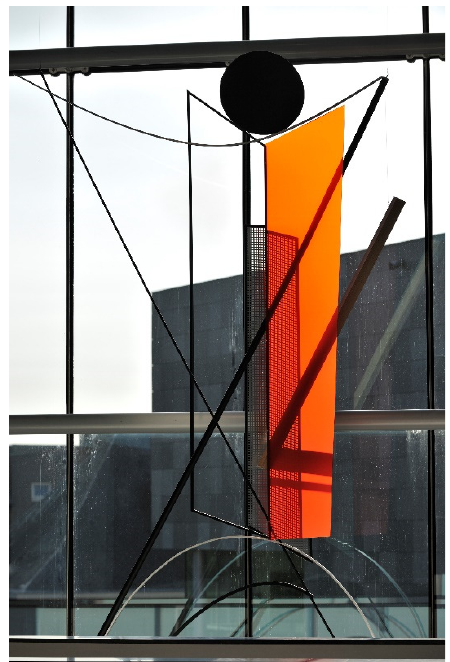
Figure 26. Model after El Lissitzky, ‘The New Man’, 1923, hanging construction by Henry Milner, 2009. Van Abbemuseum. Photo: Peter Cox.